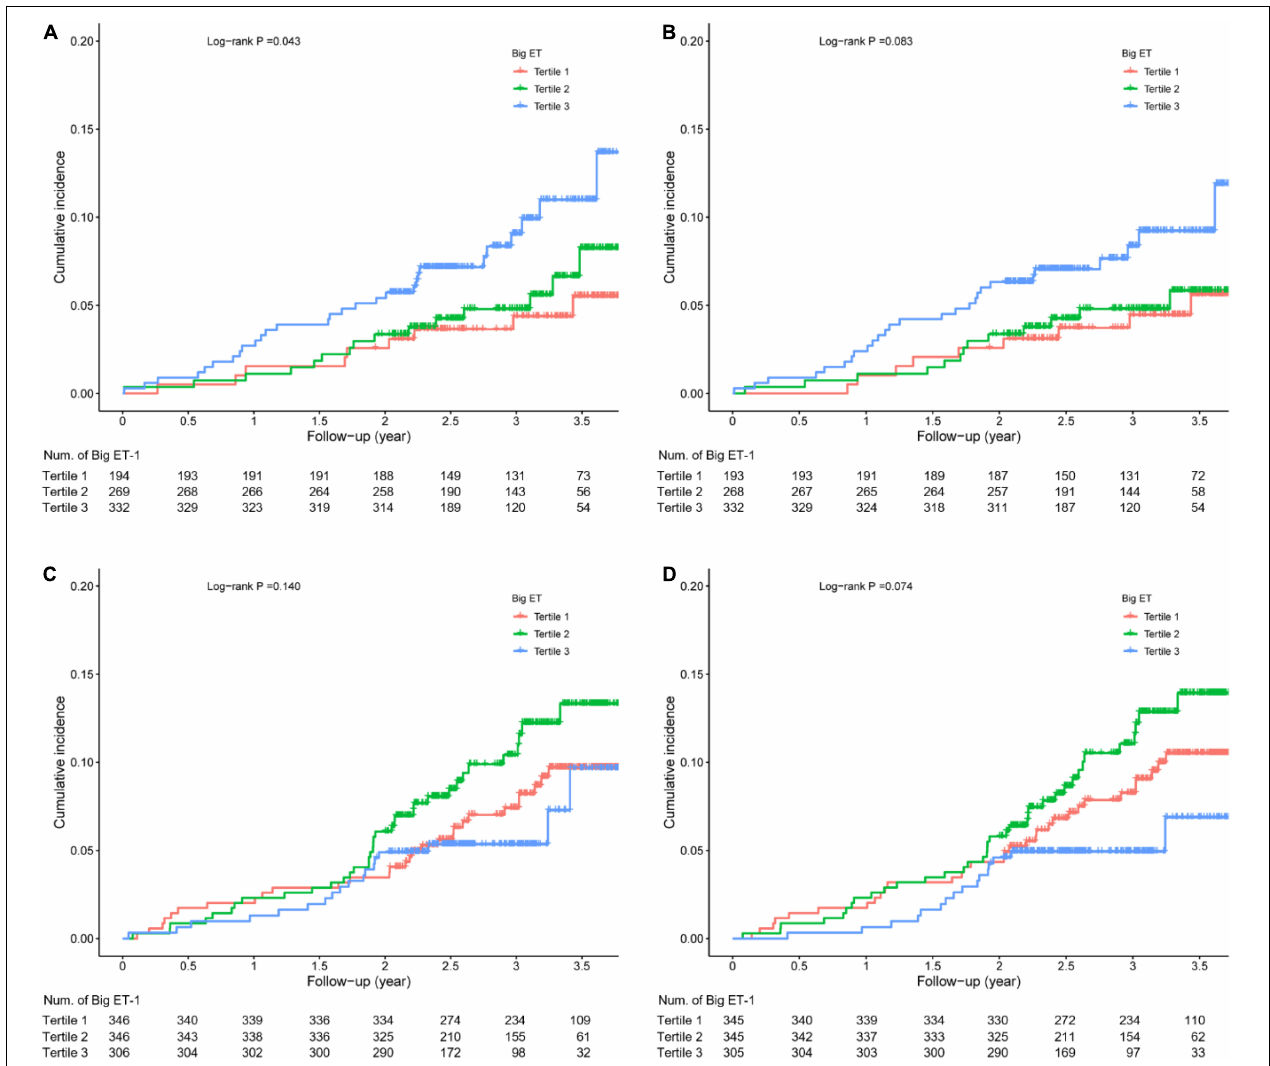
FIGURE 2 | Kaplan-Meier survival analysis. (A) Major adverse cardiovascular events (MACE) in diabetic patients; (B) secondary end points in diabetic patients; (C) MACE in non-diabetic patients; and (D) secondary end points in non-diabetic patients.